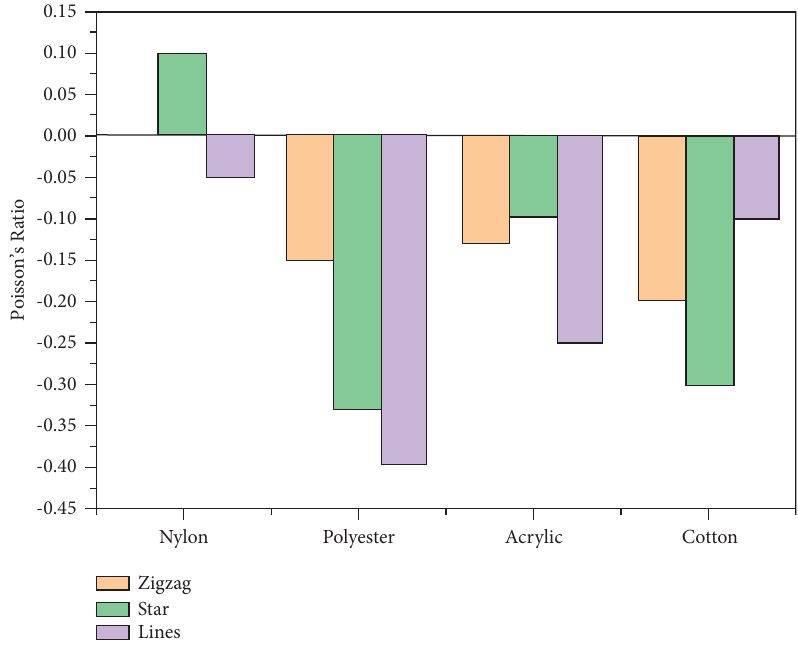
Figure 19: Comparison of NPR of diferent structures.